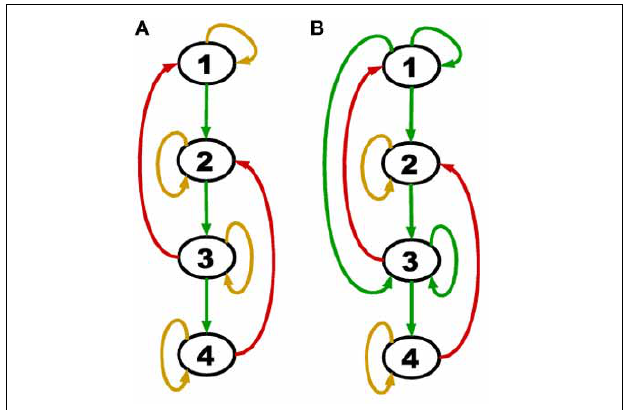
FIGURE 2 | (A) A network with all genes self degrading (yellow loop on each node) and acyclic positive regulations (green edges). (B) A network with persistence (green self loop) in addition to self-degradation and acyclic positive regulations.